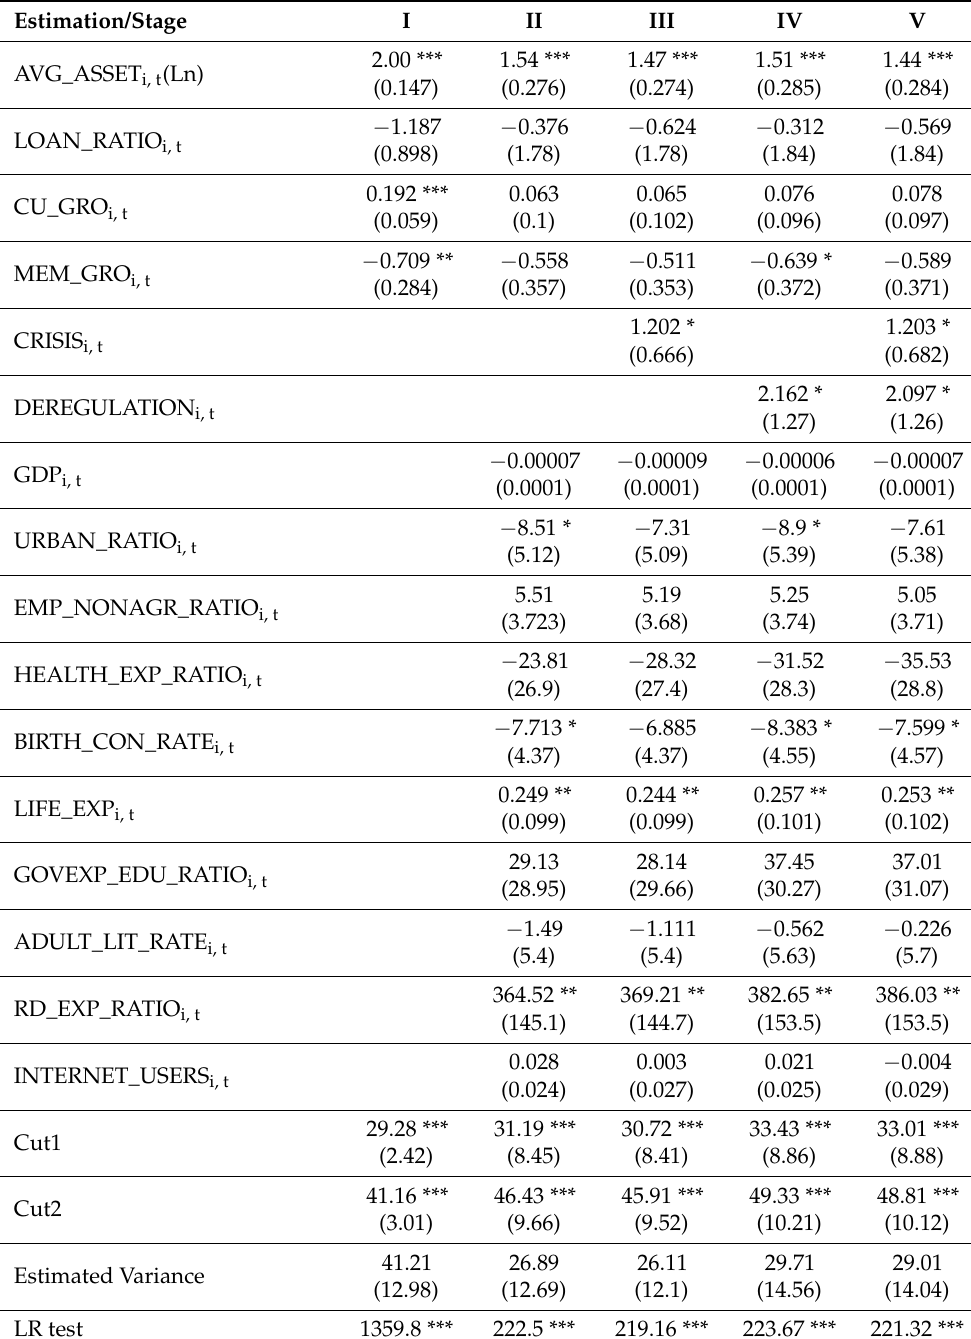
Table 6. Estimated results of the ordered logistic